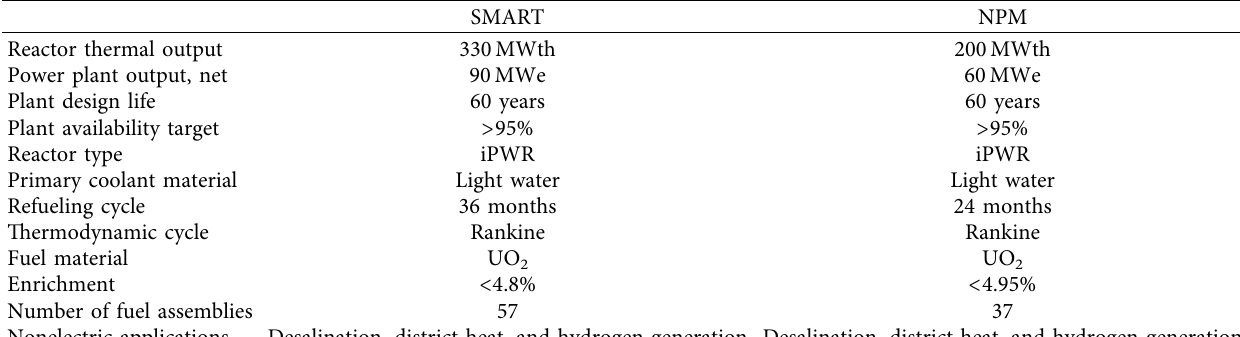
Table 1: Design parameters of SMART and NPM [22, 23].